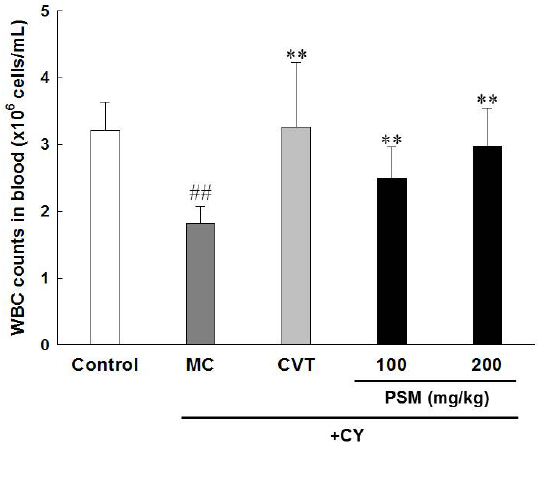
Figure 4. The effects of PSM on WBC counts in CY-treated immunosuppressed mice. Model control (MC): CY-treated immunosuppressed mice. CVT: CVT-E200™ (200 mg/kg) was used as a positive control. The data are expressed as the mean ± SD ( n = 10). ## p < 0.01 vs. vehicle-treated control group; ** p < 0.01 vs. CY-treated MC